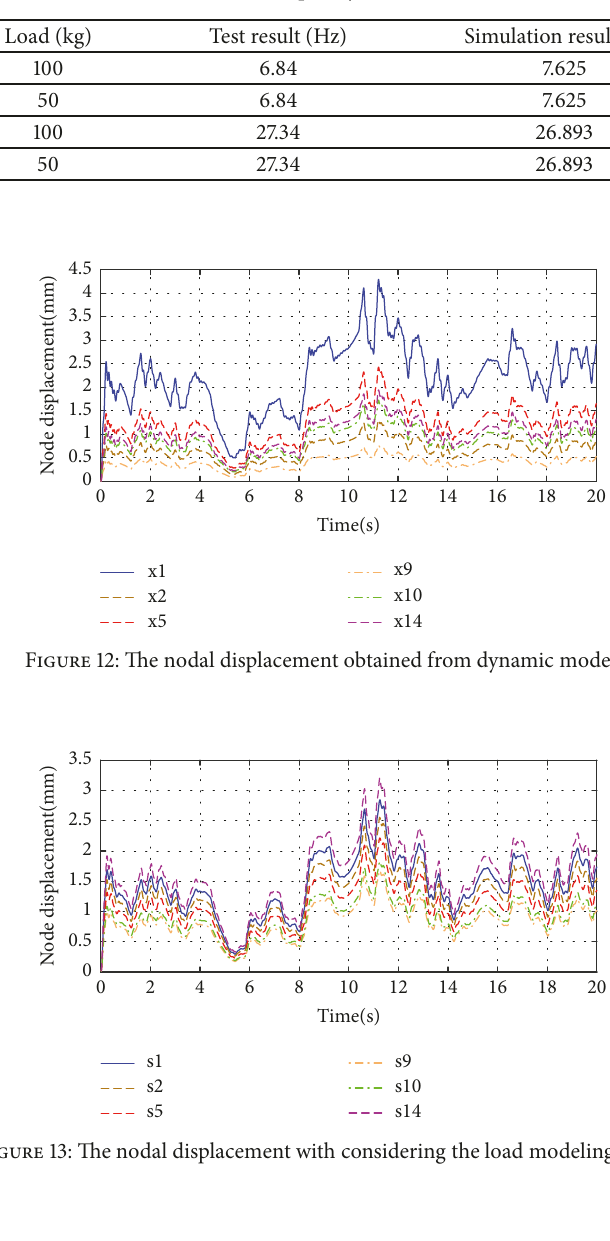
Table 2: Natural frequency measurement tests.